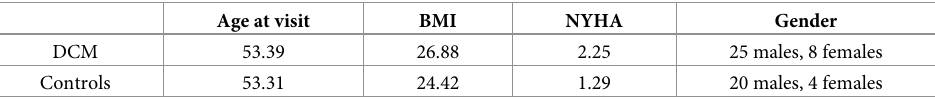
Table 1. An overview of the discovery